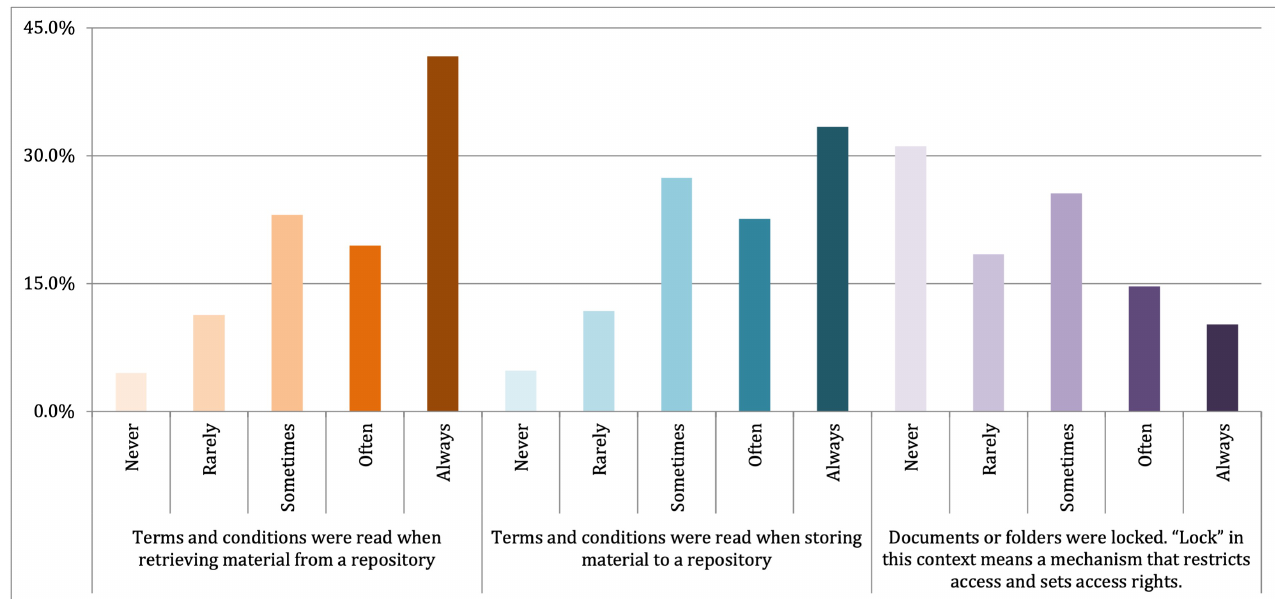
Figure 3. Indonesian scientists’ behavior in sharing digital materials.